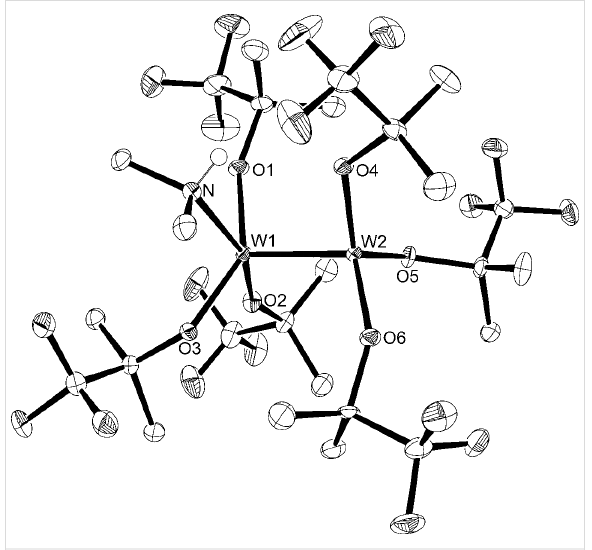
Figure 2: Molecular structure of W2F3 ·NHMe 2 with thermal displace- ment parameters drawn at 50% probability. Hydrogen atoms are omitted for